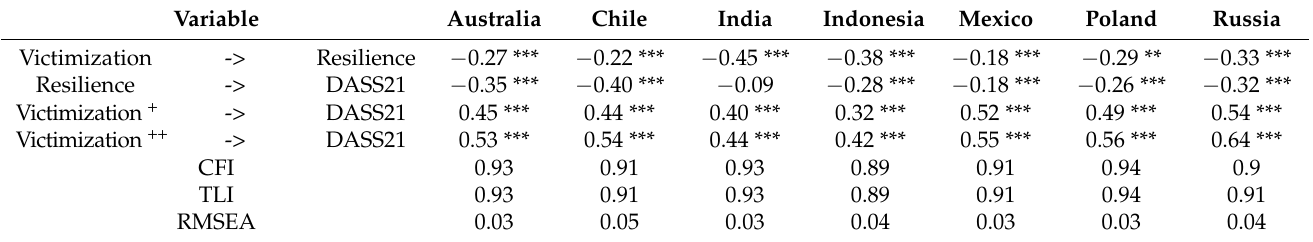
Table 5. Total and direct effects of victimization on DASS 21 and resilience as a mediator variable.